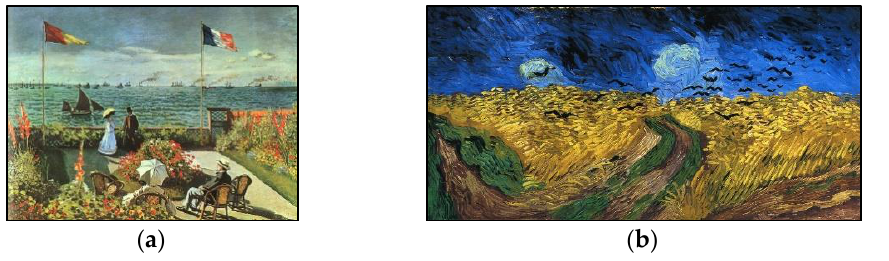
Figure 1. ( a ) Monet, “Terrace at St. Adresse, 1866”, ( b ) Gogh, “Wheatfield with Crows